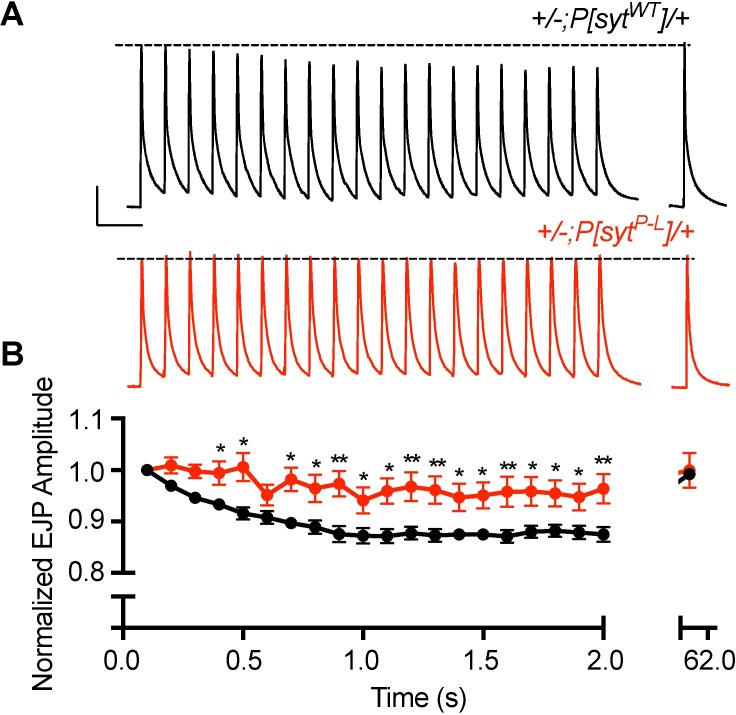
P[sytP-L] heterozygotes exhibit less depression throughout the course of high frequency stimulation, but fail to maintain this relatively increased response upon cessation of stimulation.(A) Representative traces from control and P[sytP-L] heterozygotes during a 2 second, 10 Hz stimulation train, and a single stimulus 1 minute following cessation of the train. Dotted line represents the amplitude of the initial response. Scale bar represents 10 mV, 0.2 s. (B) Mean EJP amplitudes of P[sytP-L] heterozygotes (n = 17) showed less depression compared to control (n = 14, *indicates p < 0.05, and **indicates p < 0.001). However, this relative increase in release is not maintained upon cessation of the stimulus train (p = 0.87). Error bars depict SEM.